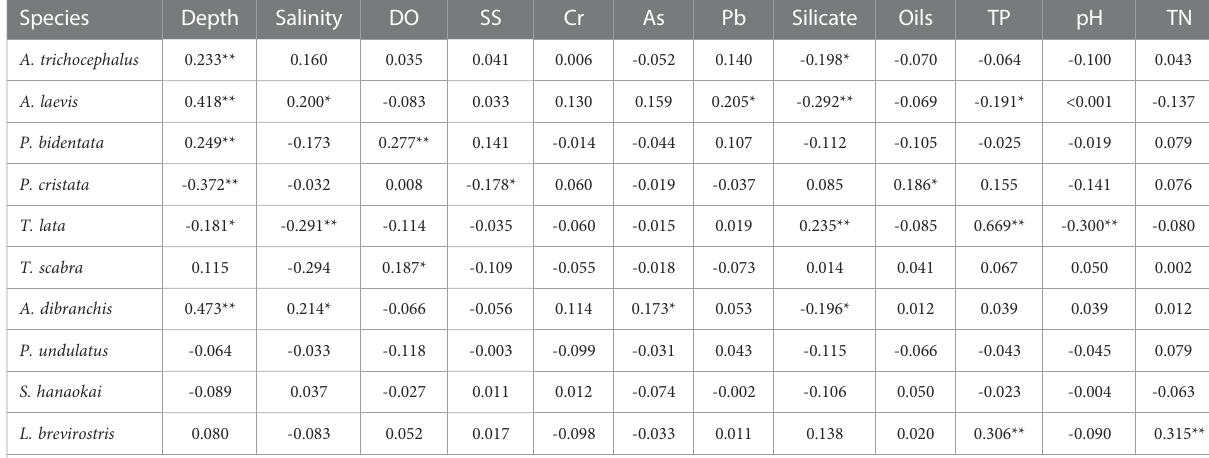
TABLE 4 Correlation analysis between densities of ten species benthic macrofauna and water environmental factors in subtidal zone near the Daya Bay Nuclear Power Plant.